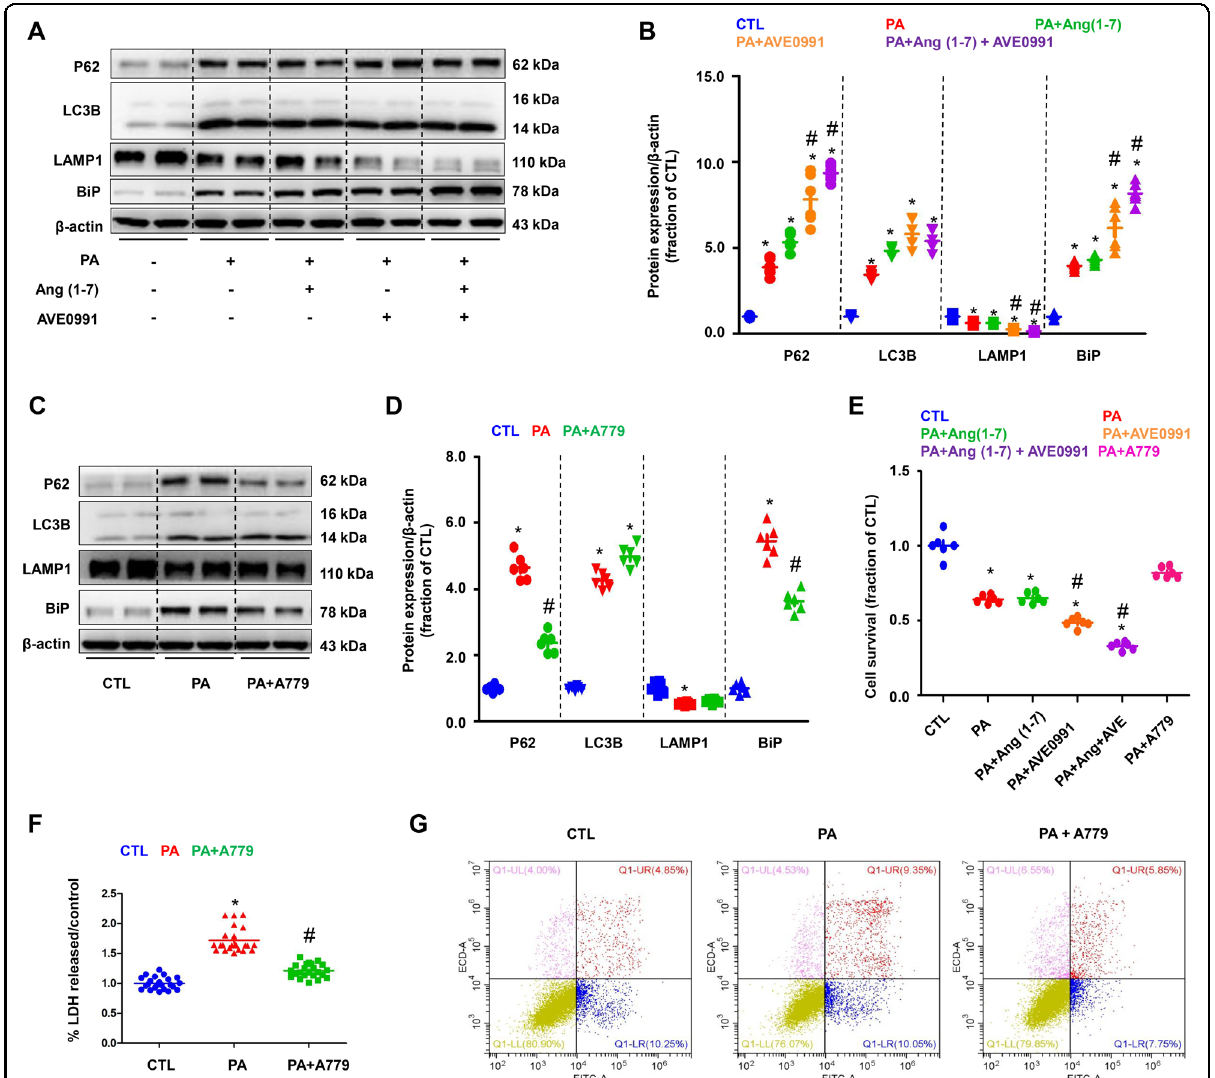
with Mas agonists Ang (1 – 7) or AVE0991. C and D Representative immunoblots and corresponding densitometry analysis of protein markers of autophagy fl ux (assessed by P62, LC3B and LAMP1) and ER stress (assessed by BiP) in PA-overload HK2 cells pretreated with Mas antagonists A779. E Cell survival ratio of Mas activation or inhibition in HK2 cells treated with PA (400 μ M) for 24 h assessed by CCK. F Lactate dehydrogenase (LDH) release by PA-overload HK2 cells pretreated with Mas antagonists A779. G Programmed cell death was detected by fl ow cytometry using Annexin V- FITC/PI apoptosis detection kit in PA-overload HK2 cells pretreated with Mas antagonists A779. Ang (1 – 7), angiotensin 1 – 7; CCK, cell counting kit 8. Data are shown as mean ± SEM; * P < 0.05 compared with CTL; # P < 0.05 compared with PA. The experiment was repeated three